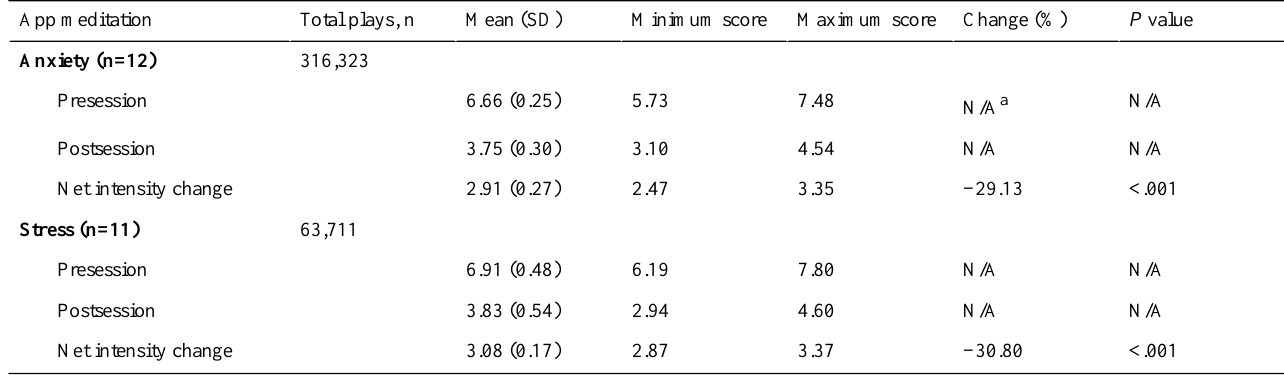
Table 2. User self-ratings results for anxiety and stress app meditations based on completed app session plays